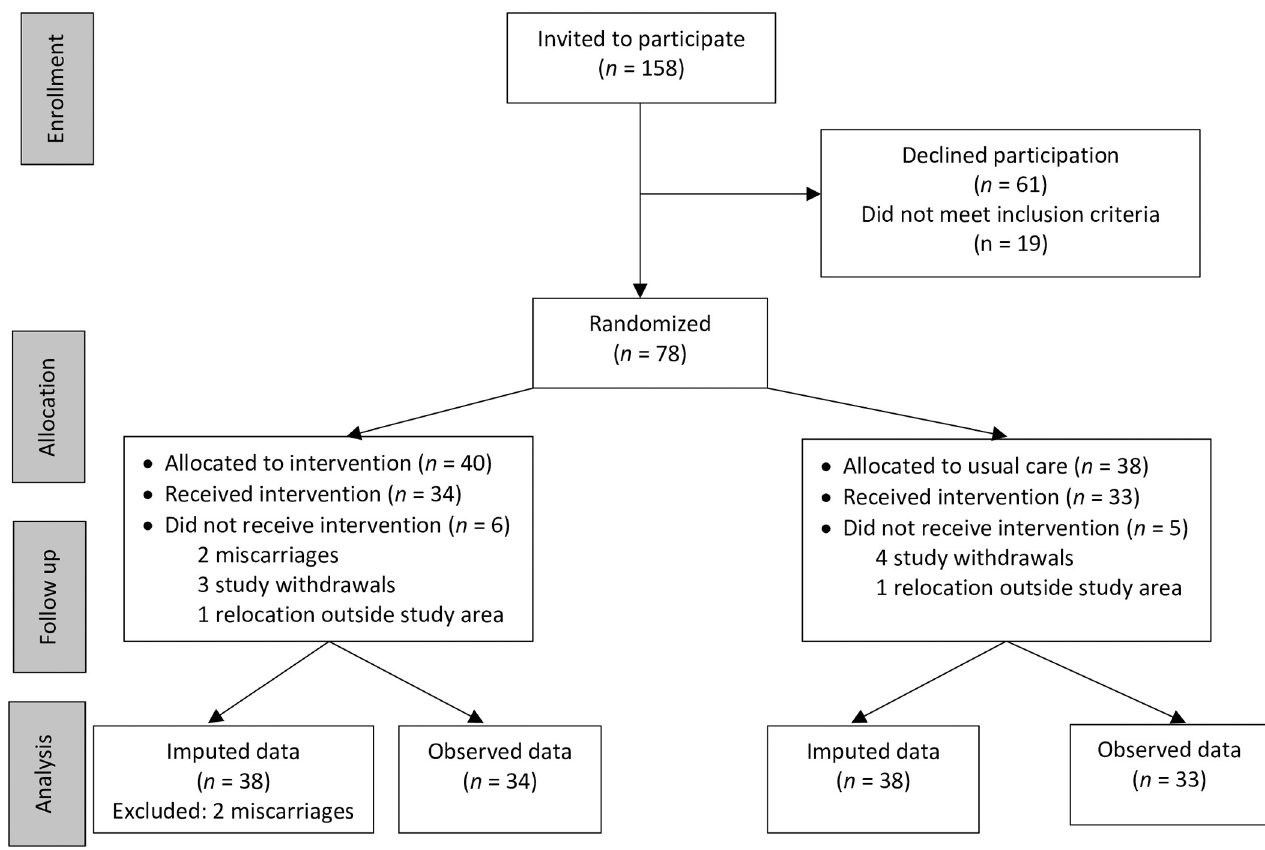
Fig 1. Flowchart of participants.